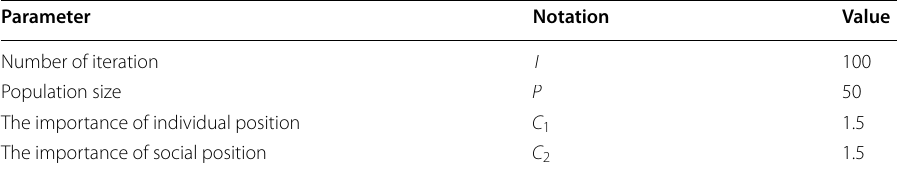
Table 1 The parameters of the proposed method Parameter Notation Value Number of iteration I 100 Population size P 50 The importance of individual position C 1 1.5 The importance of social position C 2